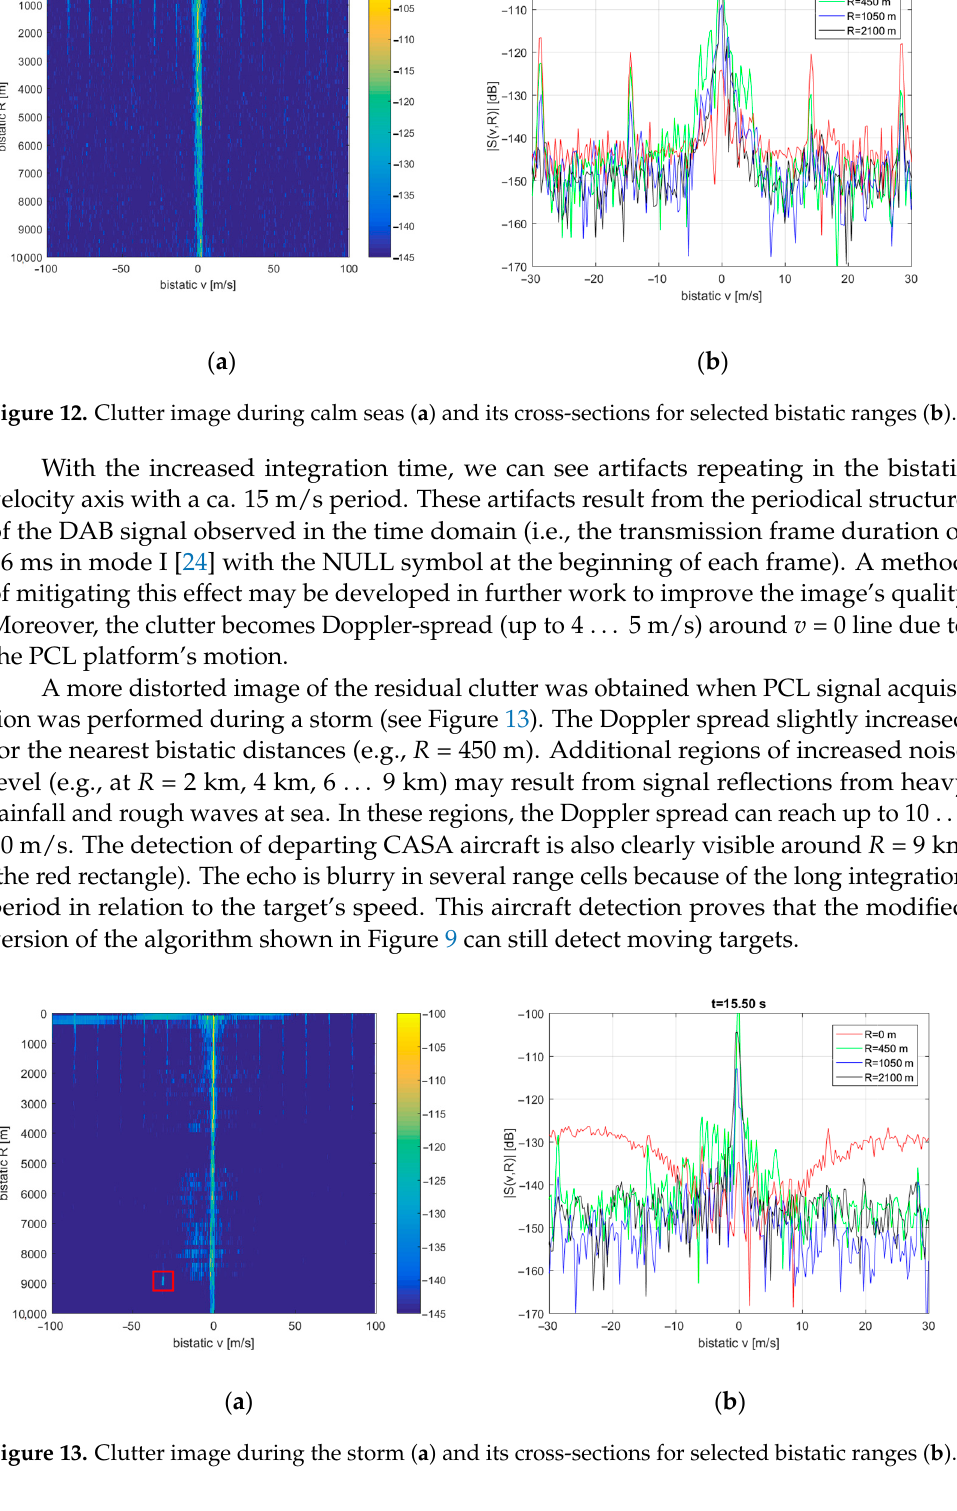
Figure 11. Change of clutter intensity caused by turning of platform with antenna array.